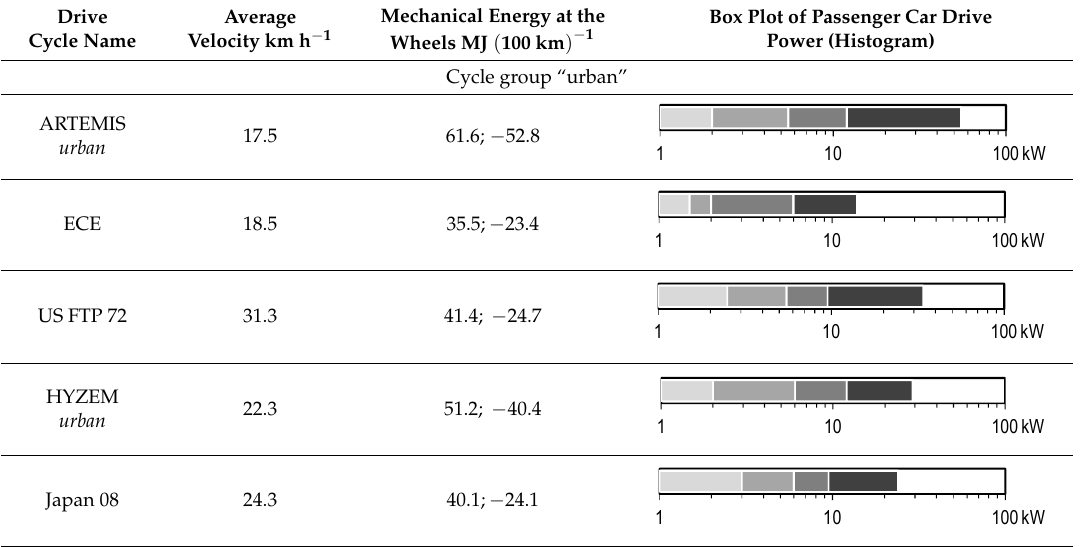
Table A2. Characterization of drive cycles used in this study. Box plots consider positive power values only. The mechanical energy displayed relates to positive and negative tractive forces. ARTEMIS Motorway is chosen with a maximum velocity of 130 km h − 1 . All values for ICV-G in the scenario “Standard” with a car mass of 1251 kg, cross-sectional area of 2.1 m 2 and air drag coefficient of 0.32.